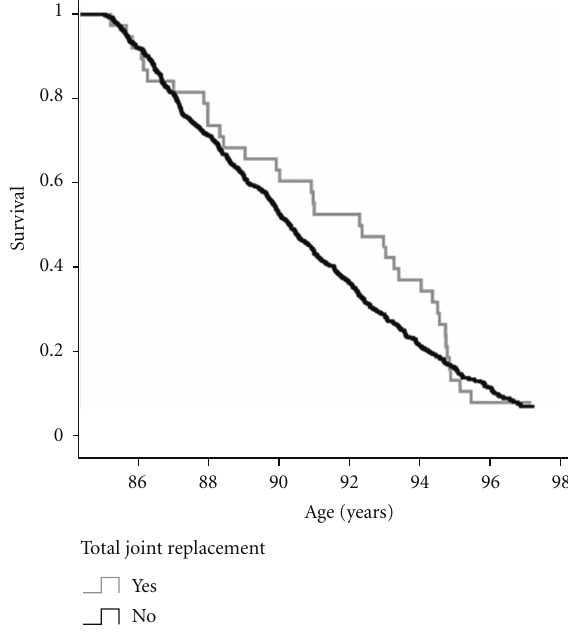
Figure 1: Mortality of participants with and without a total joint replacement in the